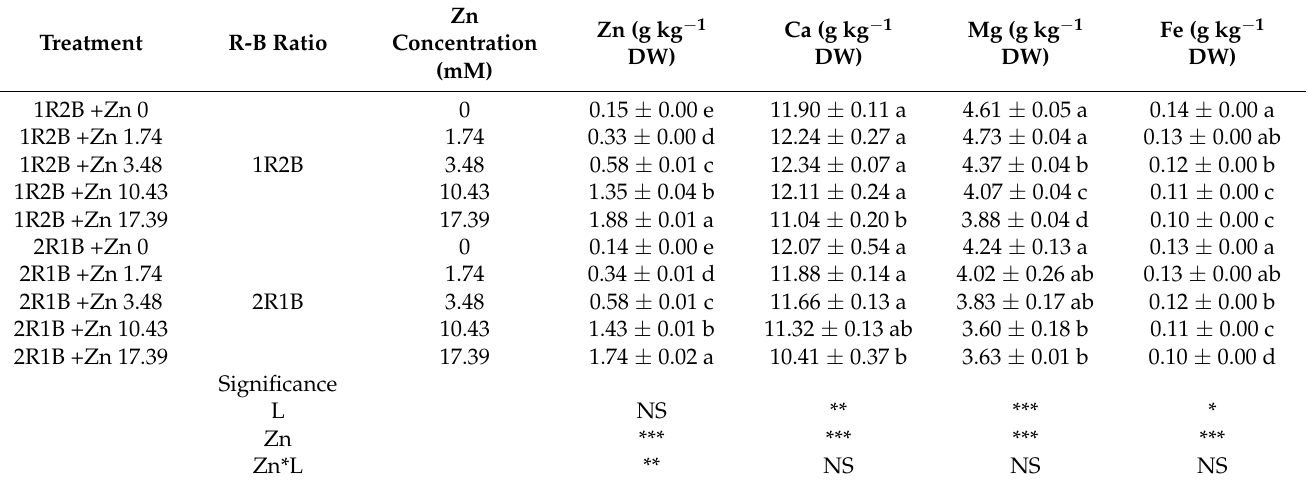
Table 2. The content of mineral elements of flowering Chinese cabbage sprouts (FCCS) under combination of Zn concentration and R-B ratio.